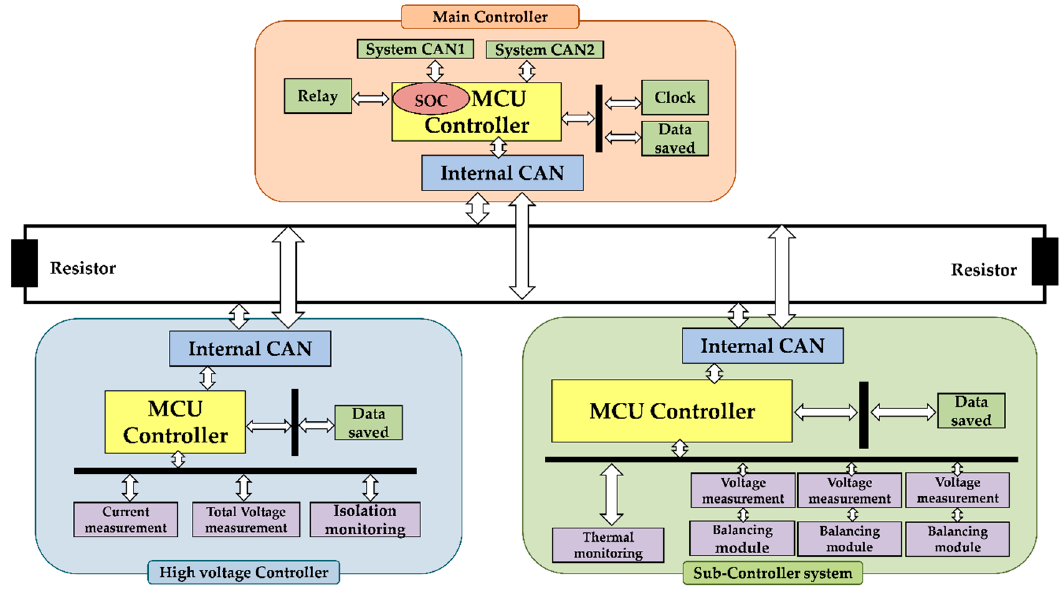
Figure 7. Functional block diagram of the supercapacitor-based energy management system.